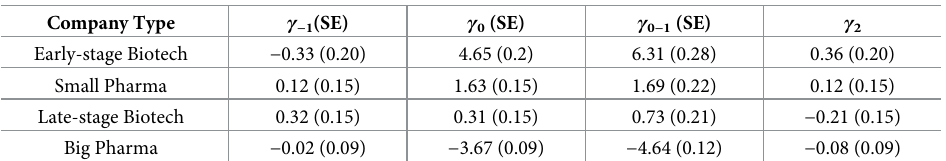
Table 4. Company sponsor category.